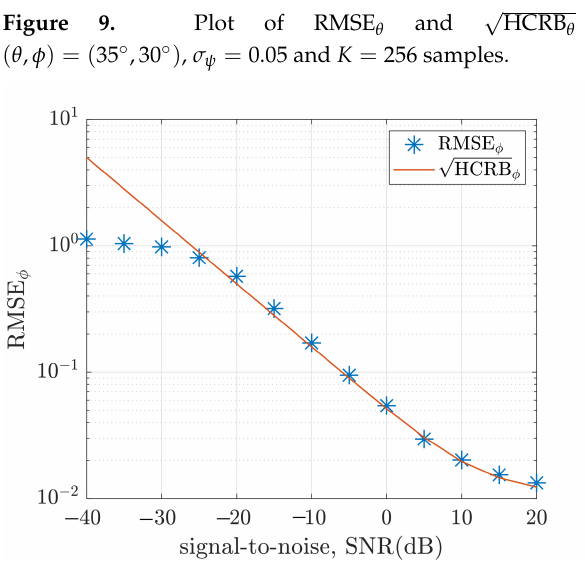
√ HCRB θ versus signal-to-noise ratio for